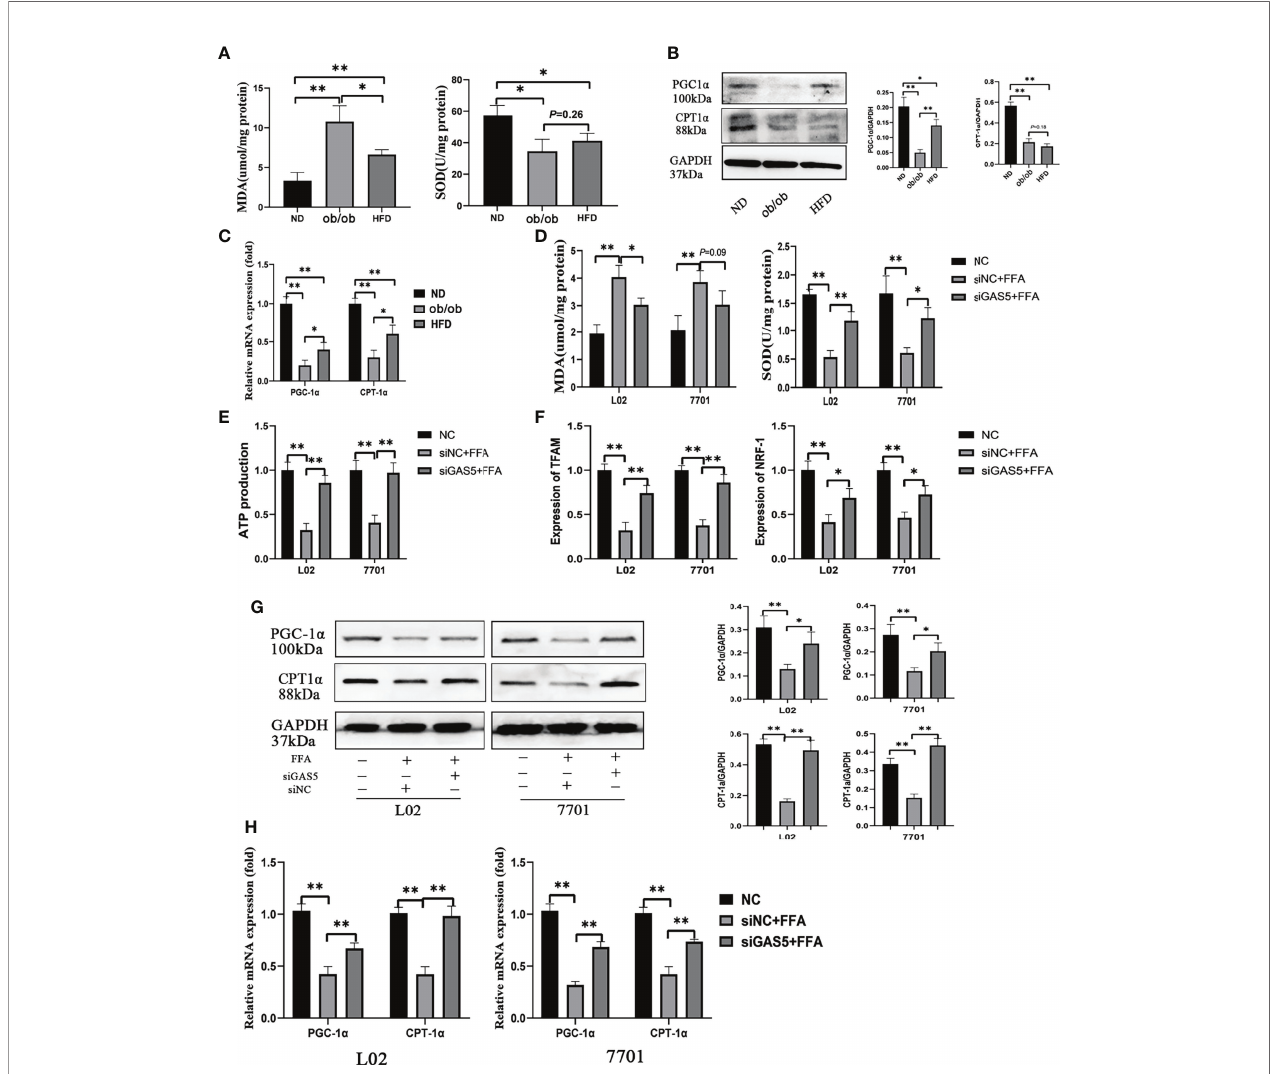
FIGURE 4 | Long non-coding RNA growth arrest speci fi c 5 (GAS5) regulates mitochondrial function. The detection of hepatic malondialdehyde (MDA) and superoxide dismutase (SOD) levels in different groups of mice (A) . The protein and mRNA expression of PGC-1 a and CPT-1 a (B, C) . Cells were transfected with small interfering GAS5-1 (described as siGAS5 in subsequent experiments) and then treated with free fatty acid. The detection of cellular MDA and SOD levels (D) . The detection of ATP production in cells of FFA, siNC plus FFA and siGAS5 plus FFA groups (E) . The expression of mRNA levels of mitochondrial biogenesis including TFAM and NRF-1 in cells of FFA, siNC plus FFA and siGAS5 plus FFA groups (F) . The protein and mRNA expression of PGC-1 a and CPT-1 a in different groups of cells (G, H) . Data are expressed as mean ± standard error of mean. * P < 0.05 and ** P < 0.01, n =